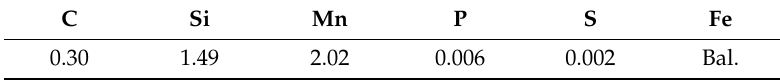
Table 1. Chemical composition of the alloy used in this study (mass